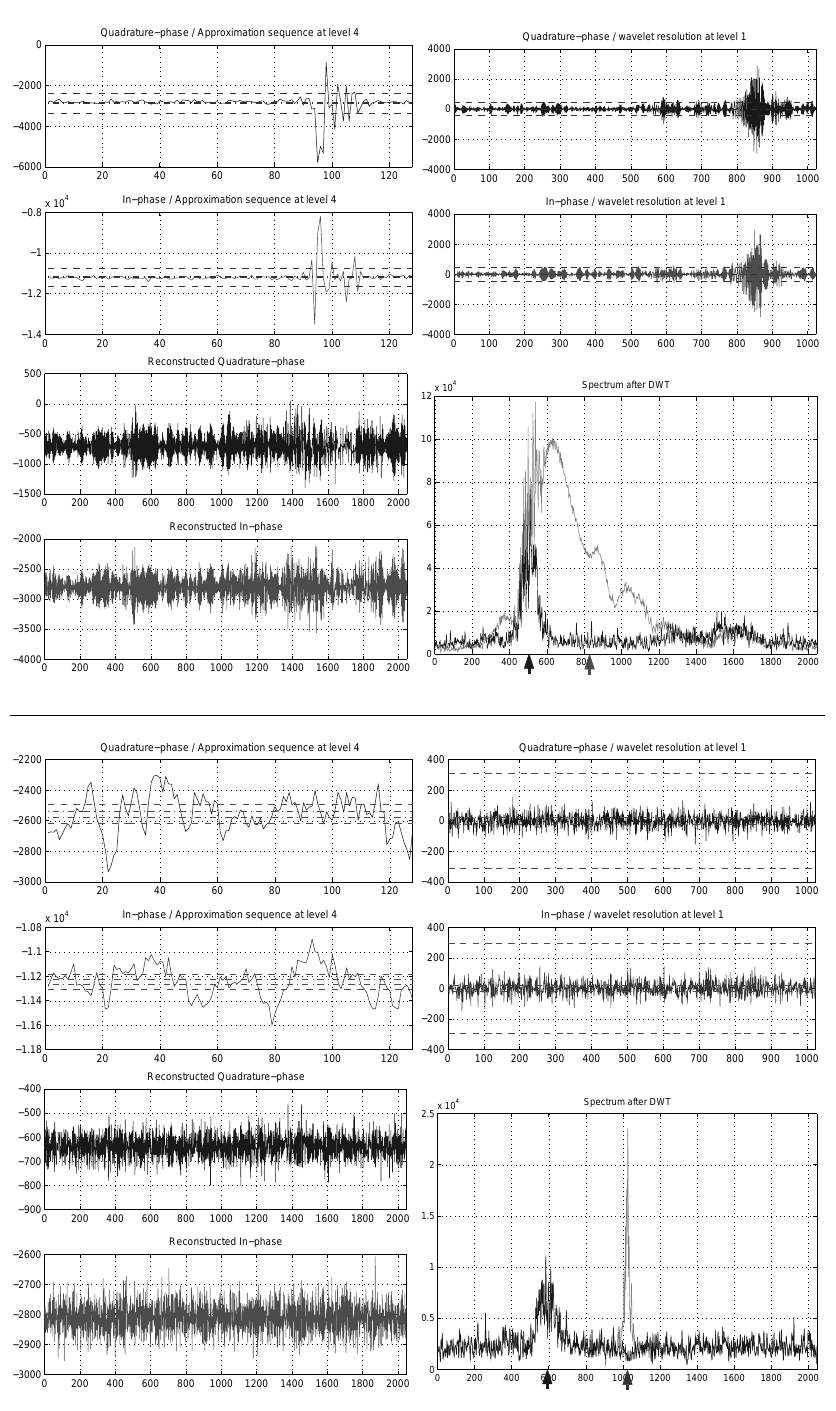
Fig. 7. Decomposition ( α k und β 1 k ), reconstruction and Fourier power spec- trum of gate 17 (top) and gate 11 (be- low). The black curves in the power spectra representations display the de- contaminated spectra. One clearly rec- ognizes are the differences of moment estimations; see the computed first mo- ment before (gray arrow) and after (black arrow) the filtering